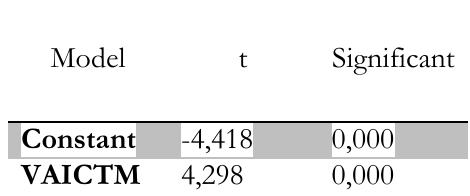
Table 2. Results (t test)